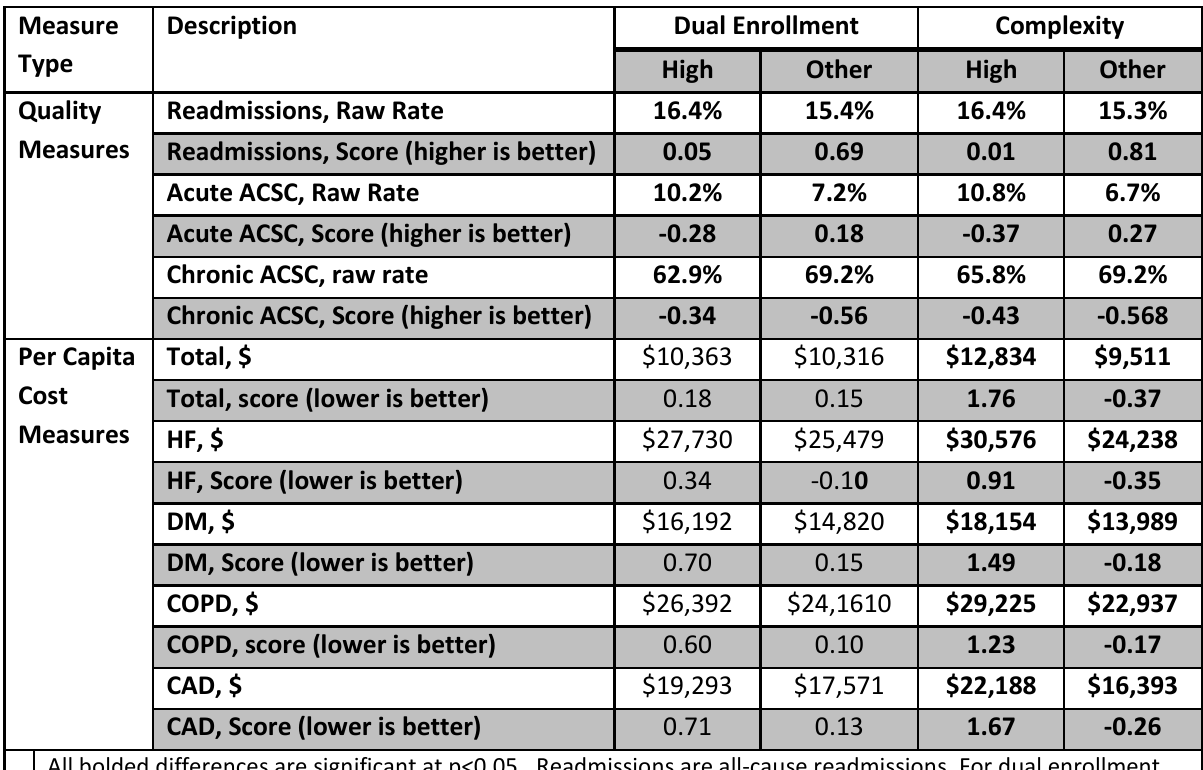
Table 10.11. Practice-Level Performance on Mandatory Quality and Cost Measures, Stratified by Proportion of Dually-Enrolled or Complex